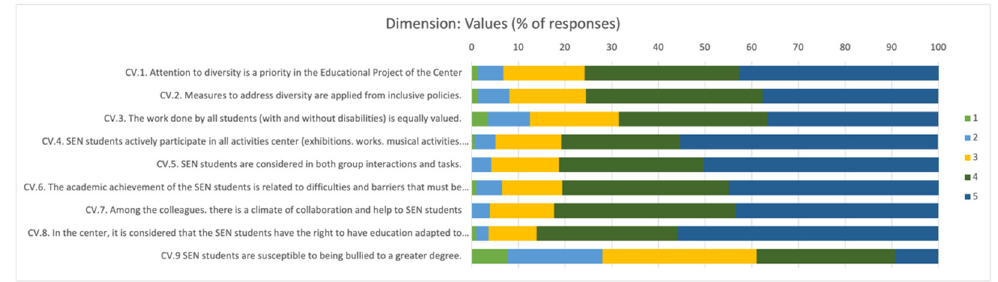
Figure 1. Percentage of responses about teachers’ opinions about the presence of inclusive values in their schools.1: Never; 2: R arely; 3: Occasionally; 4: Almost always; 5: Always.